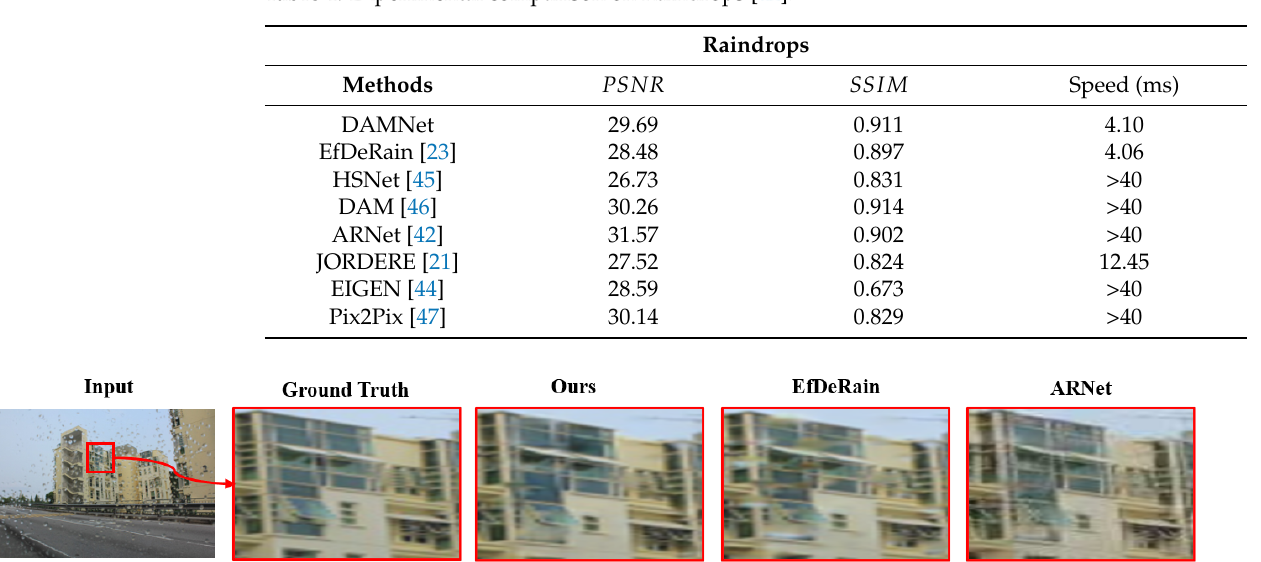
Table 4. Experimental comparison on Raindrops [42].